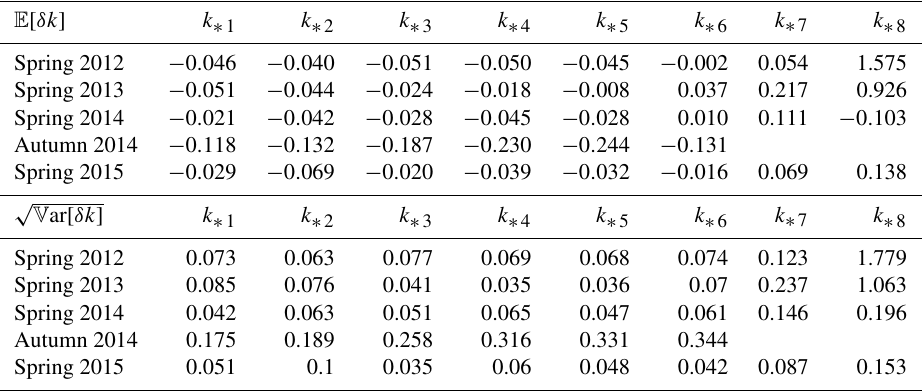
√ V ar [ δk ] ; see Eqs. 23,